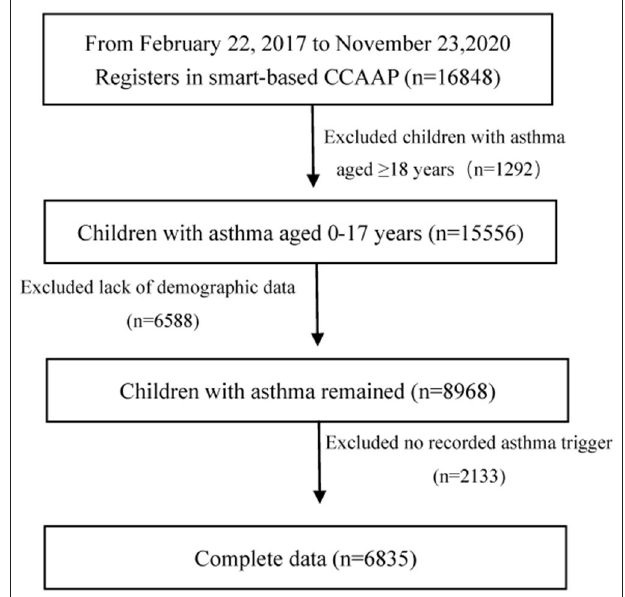
FIGURE 1 | Study population flow chart (n, number; CCAAP, China Children’s Asthma Action